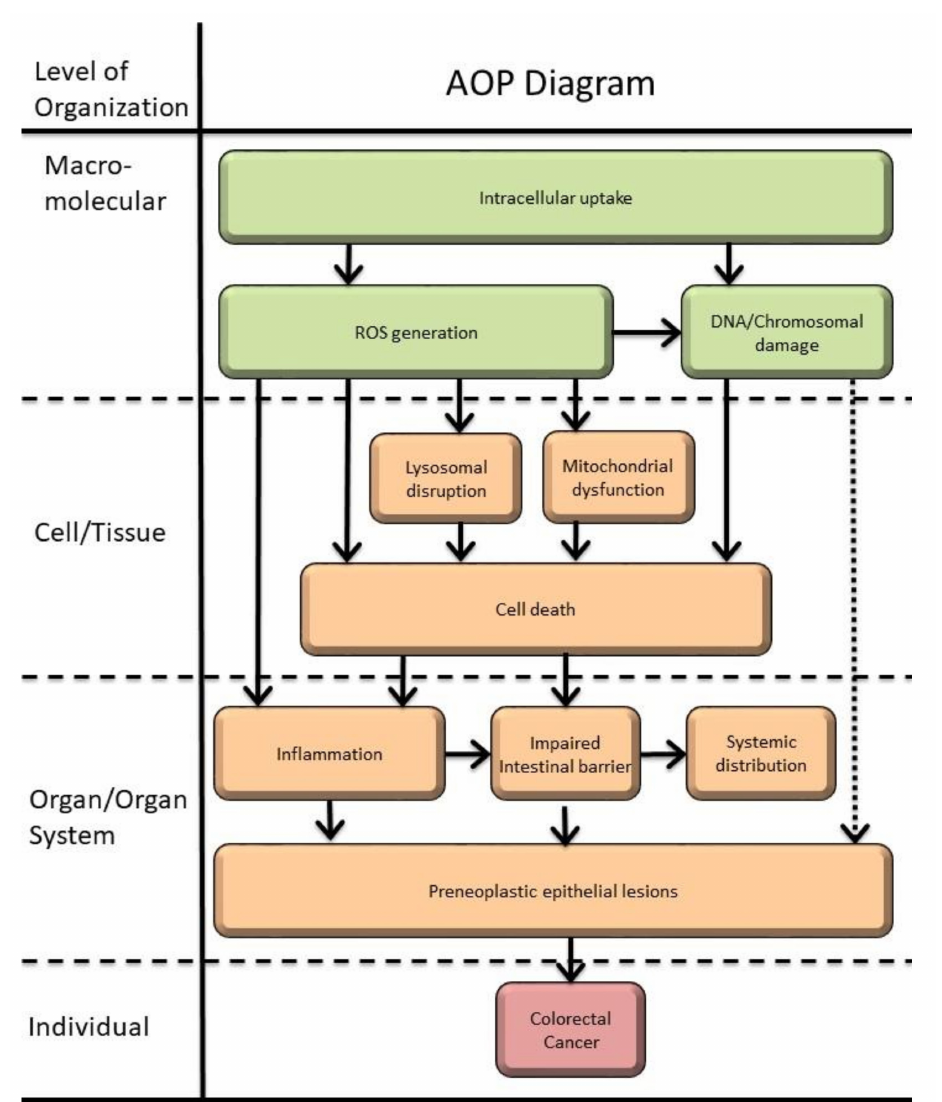
Figure 4. Proposal of a putative AOP model upon TiO 2 -NPs ingestion leading to colorectal